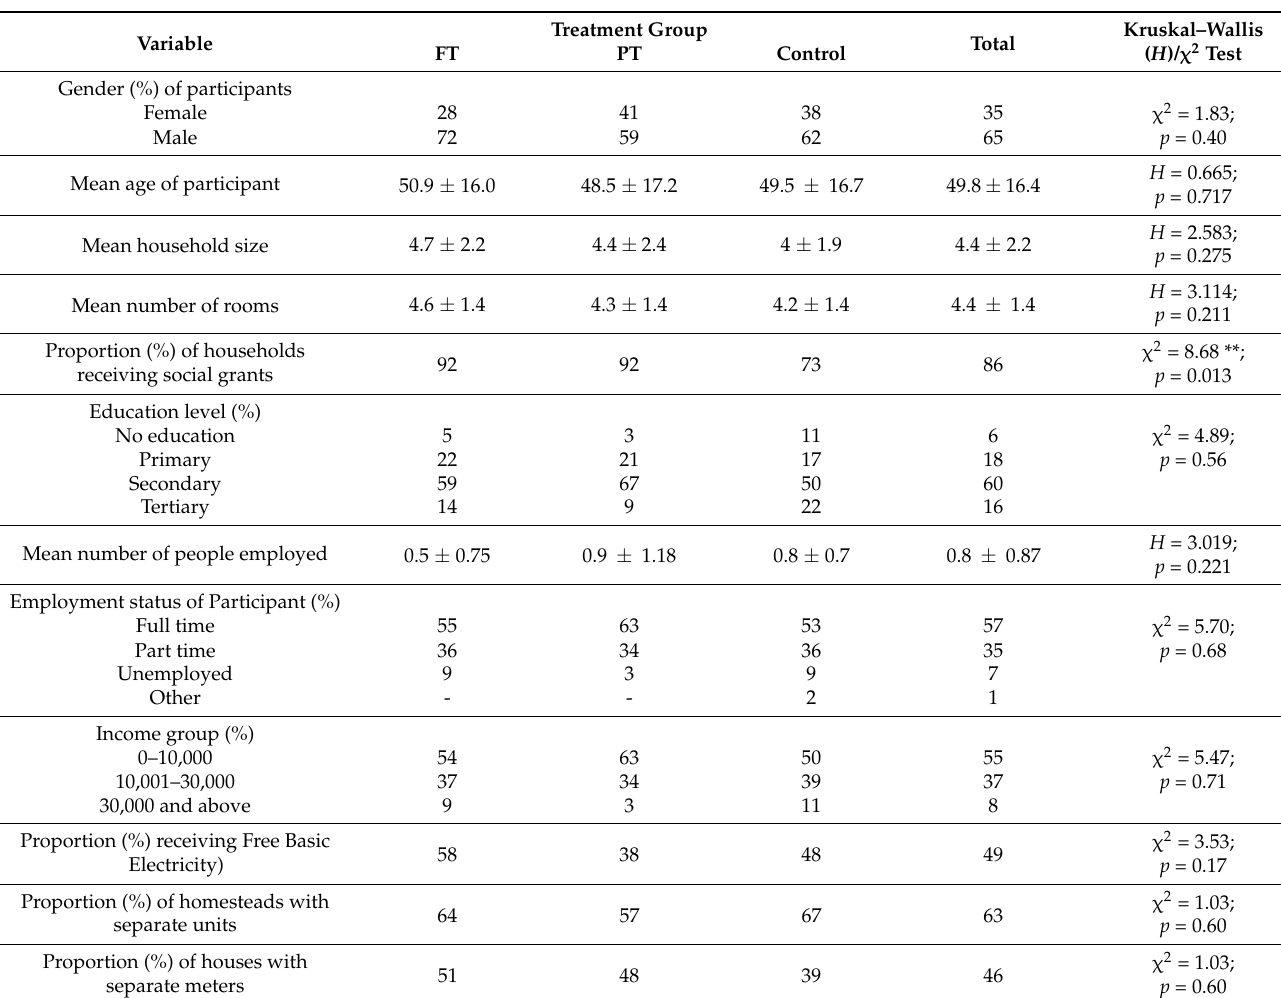
Table 1. Socio-demographic features of